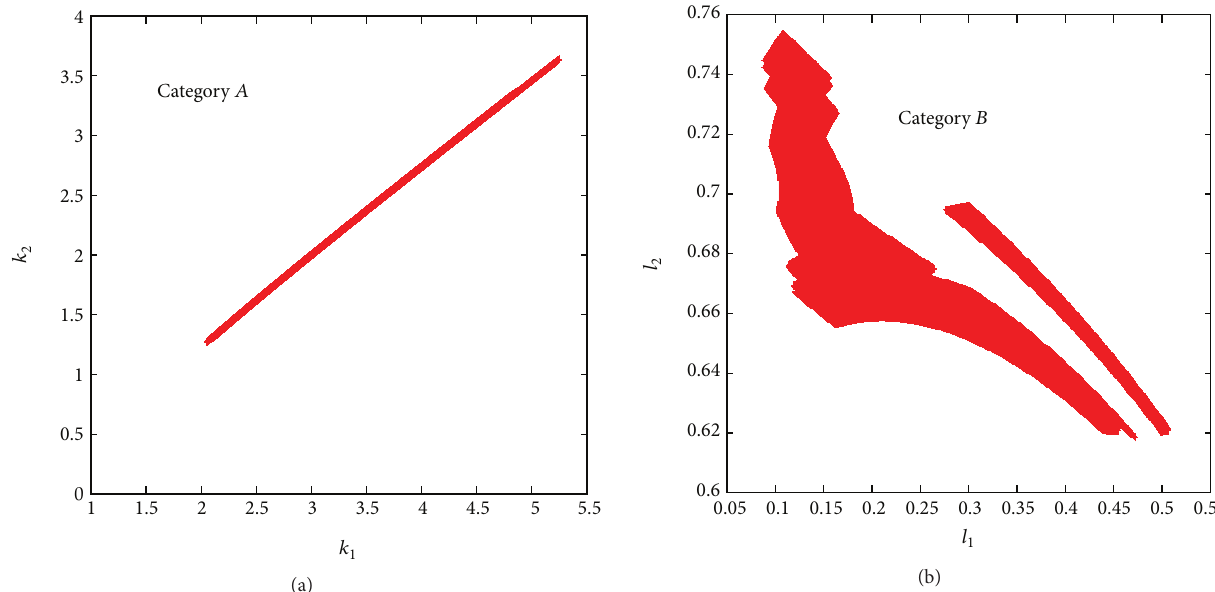
Figure 1: Variation of 𝑘 1 and 𝑘 2 in Category 𝐴 and of 𝑙 1 and 𝑙 2 in Category 𝐵 with 𝜇𝜏 symmetry over the 3𝜎 allowed ranges of Δ 2 21 , |Δ 2 32 | , and 𝜃 12